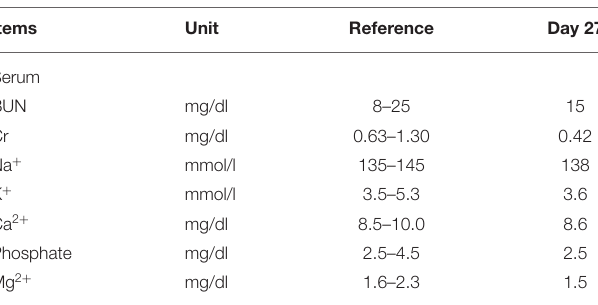
TABLE 2 | Laboratory data after 16-day withdrawal of